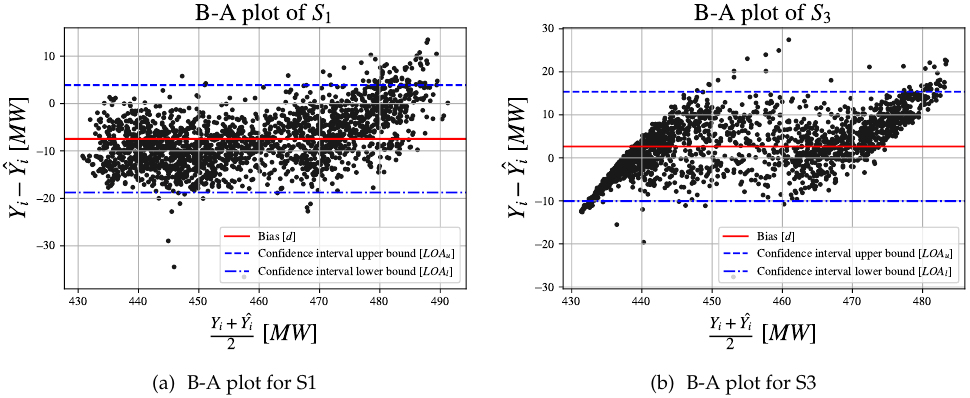
Figure 6. Bland-Altman plots for all five MLP configurations designed with GA implementation with MSE as a fitness